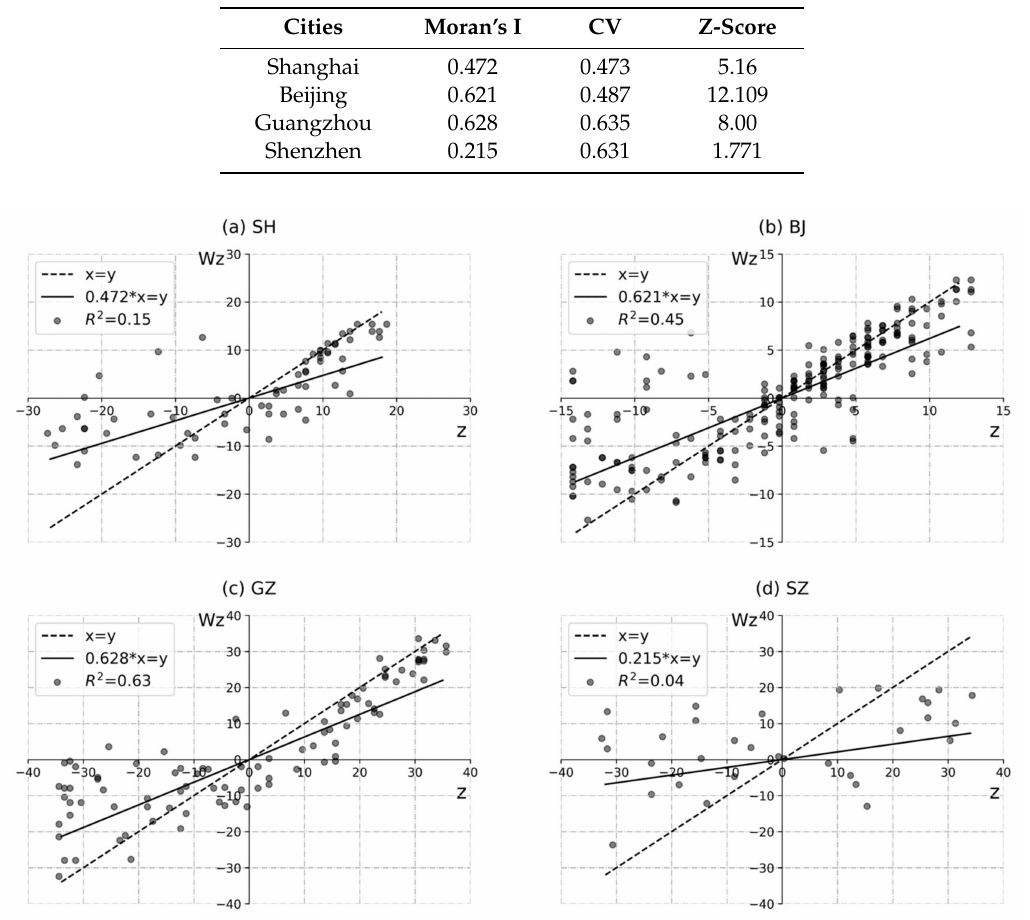
Figure 8. Scatter diagrams of Moran’s I in four study